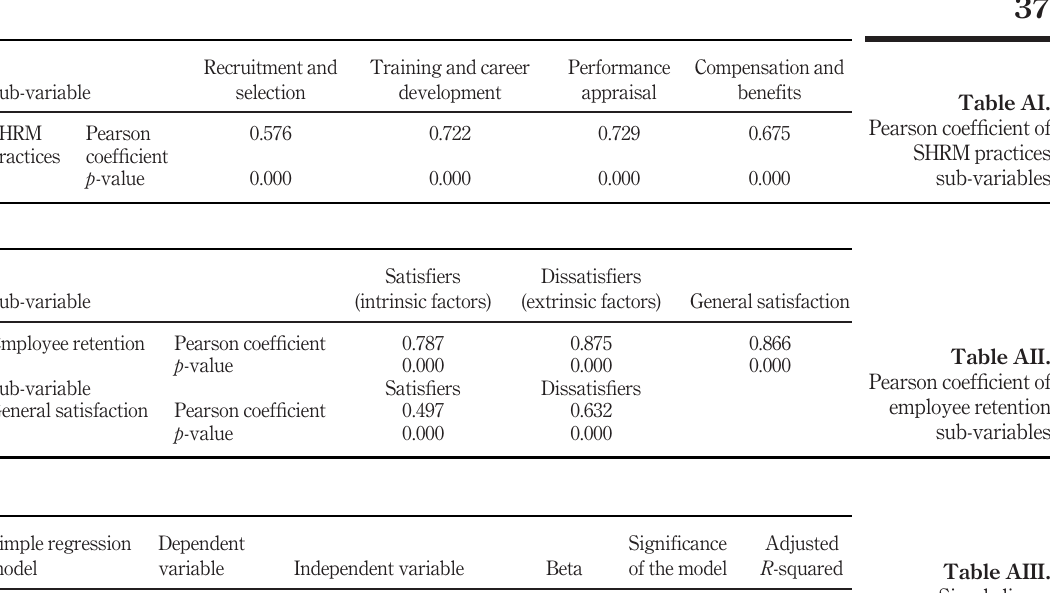
Table AIII. Simple linear regression models of the